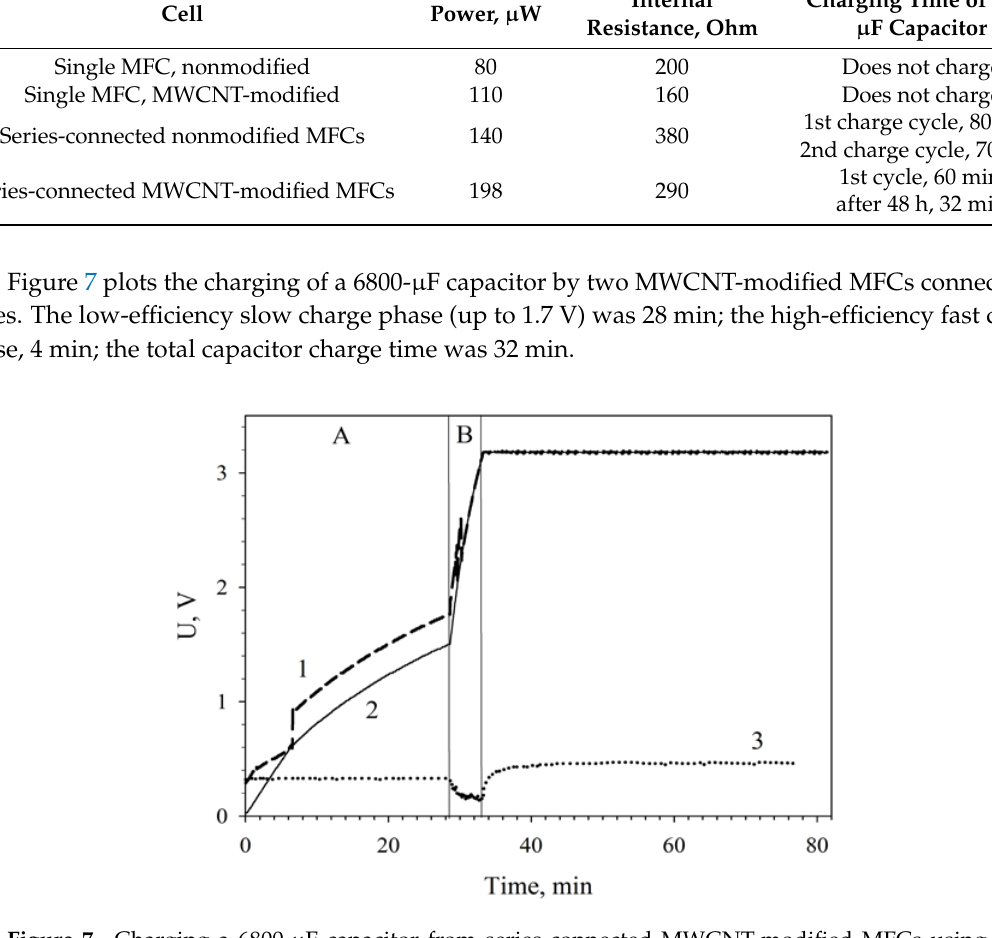
Figure 7. Charging a 6800-μF capacitor from series-connected MWCNT-modified MFCs using